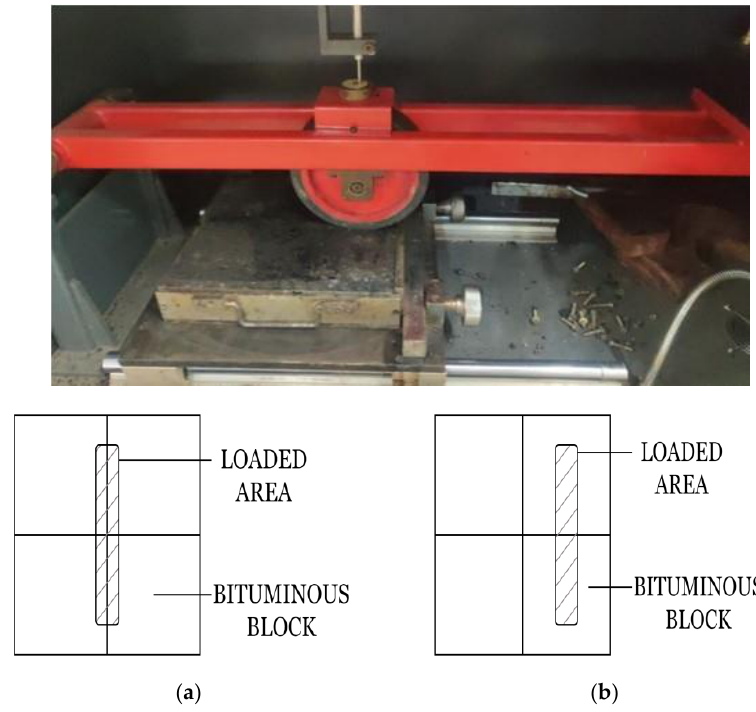
Figure 3. Wheel rut tester and loaded area(hatched area) ( a ) over the joint; ( b ) over the center.